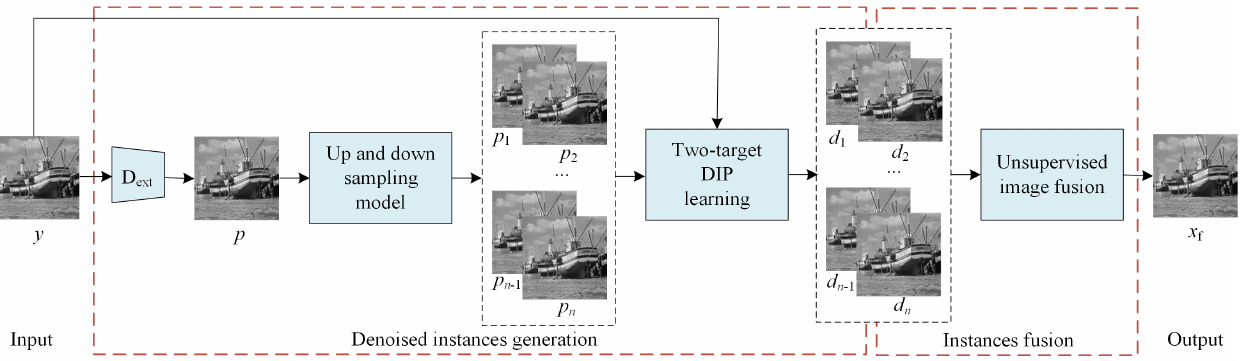
Figure 4. The overall flowchart of the proposed